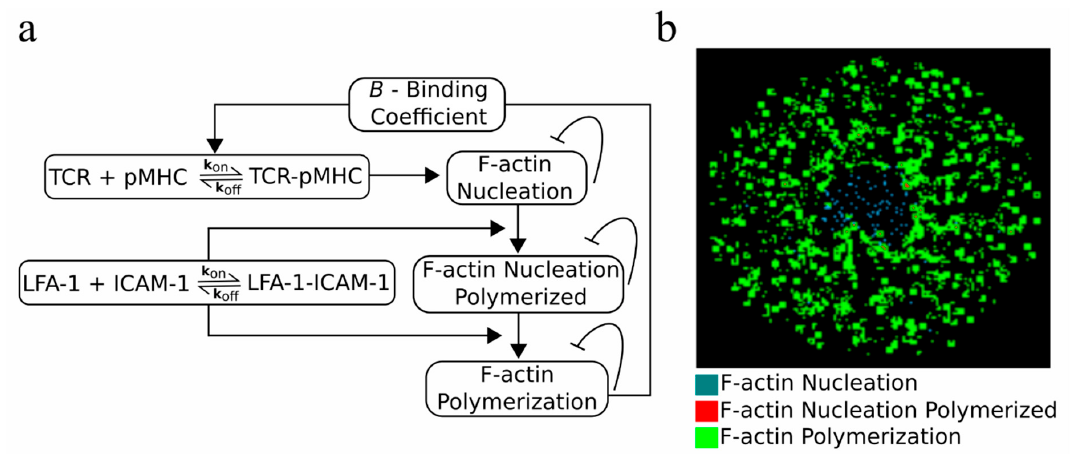
Figure 5. F-actin foci model: ( a ) a model of F-actin foci formation and ( b ) the formed F-actin foci during IS formation. F-actin nucleation: cyan, F-actin nucleation polymerized: red, and F-actin polymerization: green.